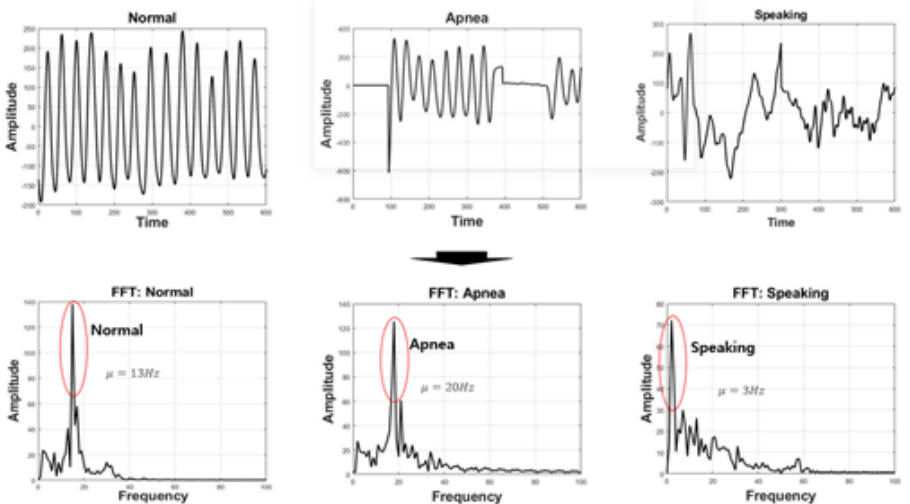
Figure 5. Frequency analysis of signals in the respiratory states.